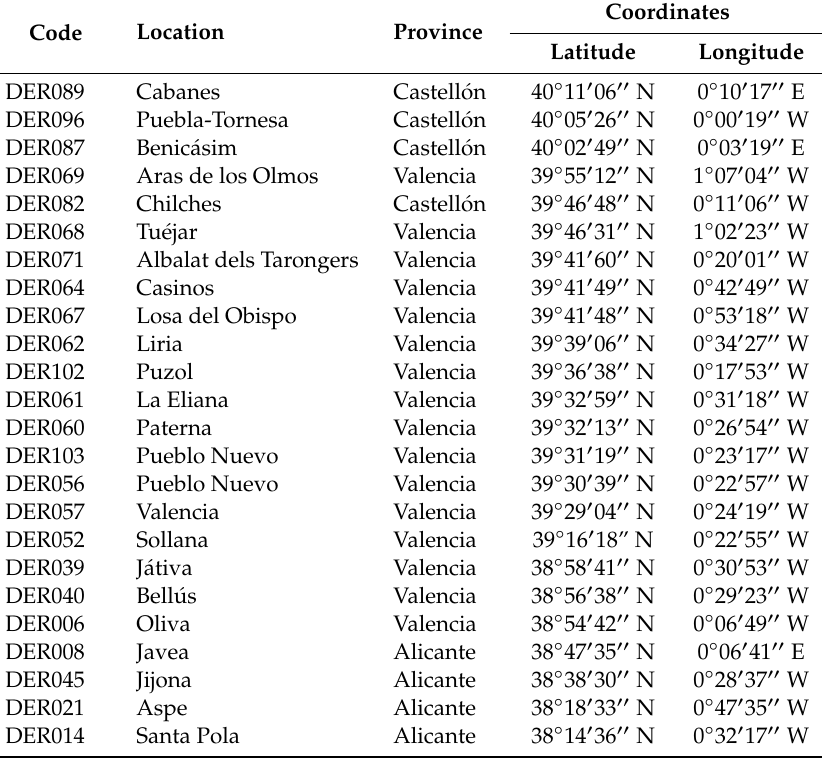
Table 1. Geographical origin of the wild populations where the seeds were